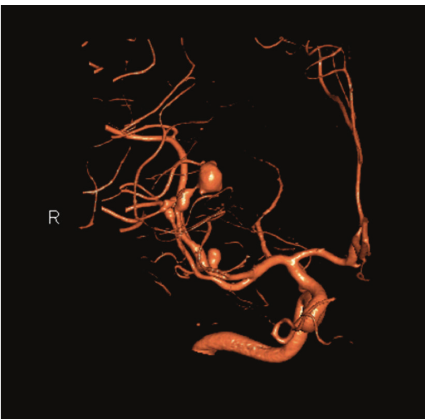
Figure 3: Anterior-posterior view of cerebral angiographic (DSA) image demonstrating an 8mm right M3-MCA fusiform aneurysm and a 4 mm M2-MCA saccular aneurysm.